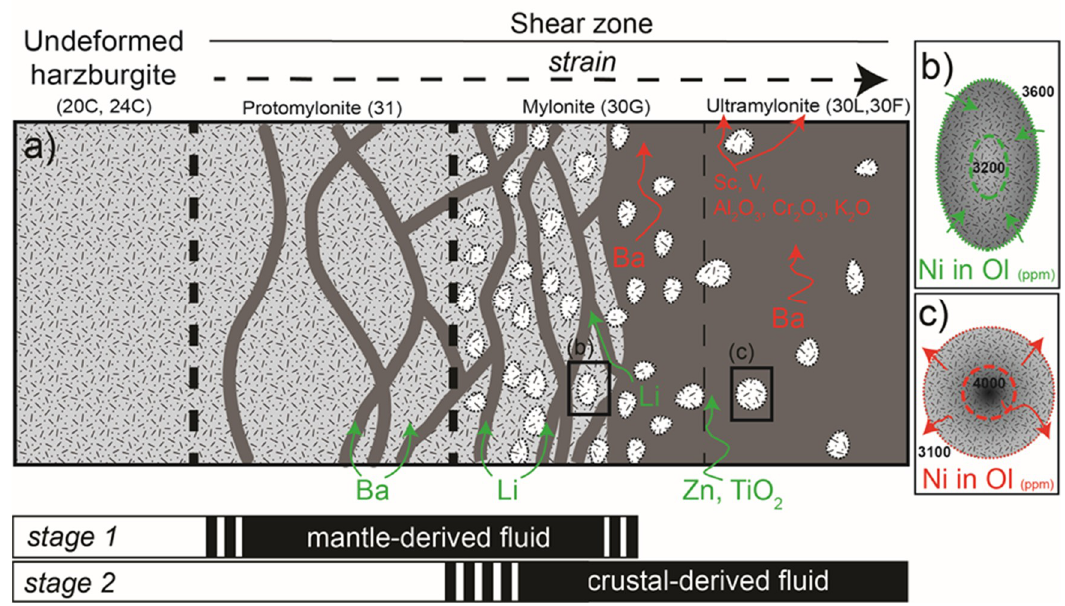
Figure 11. Cartoon summarizing the main observed variations in term of major and trace elements in the mineral phases: ( a ) Scheme of the transition from coarse-grained harzburgite to mylonite and ultramylonites. Arrows and text in red and green refer to enrichment and depletion, respectively, of elements within minerals and rocks. ( b , c ) Opposite chemical trends observed within olivine porphyroclasts from different sectors of the shear zone. The black bars on the bottom represent the domains of the shear zone affected by the different fluids.